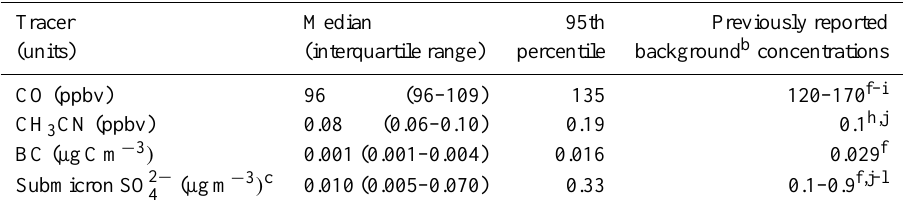
Table 6. A comparison of background concentrations of biomass burning and pollution tracers as previously reported to those in the ARCTAS-B data set in air masses that would be defined as background using only the CN PCASP equivalent a cutoff of ≤ 127particlescm − 3 . Data are out-of-cloud and from altitudes < 2.1km due to instrument limitations above this